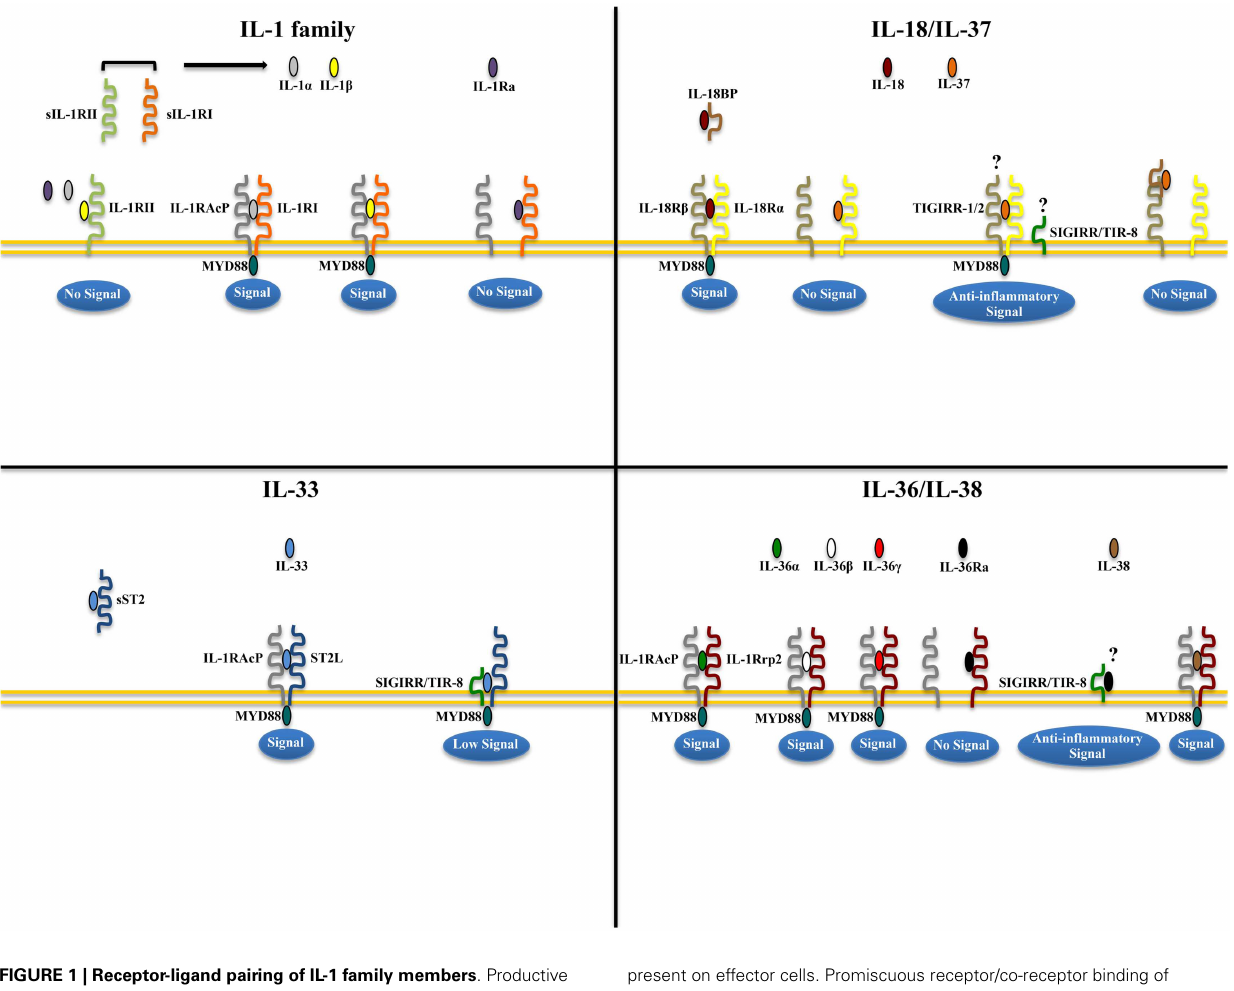
present on effector cells. Promiscuous receptor/co-receptor binding of agonists and antagonists imply that IL-1 family members cannot be considered in isolation, but in the context of other IL-1 family members that can influence their overall integrative effects and impact on disease